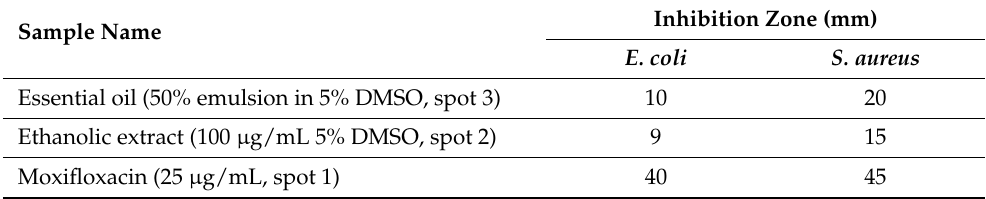
Table 6. Antibacterial activity of the essential oil and ethanolic extract against E. coli and Staphylo- coccus aureus